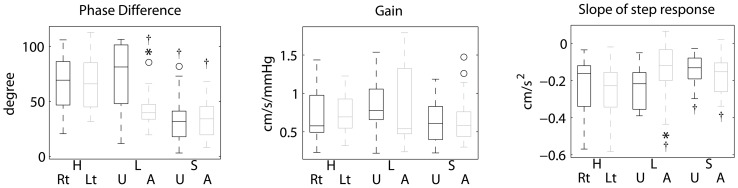
Statistical distributions of the autoregulatory parameters for each category are shown above.A) Phase difference (PD) from the affected side in the large-artery atherosclerosis group is significantly lower than the contralateral side as well the healthy group. PD from the small-artery occlusion group is bilaterally lower than those in the healthy group but there is no difference within the group. B) No statistical difference is detected using gain. C) The results of the slope of step response agree with the findings in PD. Flatter slope (the value of the slope of step response is closer to zero) is observed within the affected side in large-artery atherosclerosis group than in other conditions. The slope in the small-artery occlusion group is also flatter than the healthy controls only. H, L, and S denote the three groups as Figure 1. Rt and Lt stand for right and left side, respectively, for the healthy controls. U and A denote unaffected and affected sides, respectively, for the patients. For each box plot, the central mark is the median and the edges of the box are the 25th and 75th percentiles, the whiskers extend to the most extreme data points which are not outliers, and the outliers are plotted individually as ‘○’. *denotes P<0.05 for comparing between two sides within the same group. † denotes P<0.05 for comparing with the overall of healthy group.